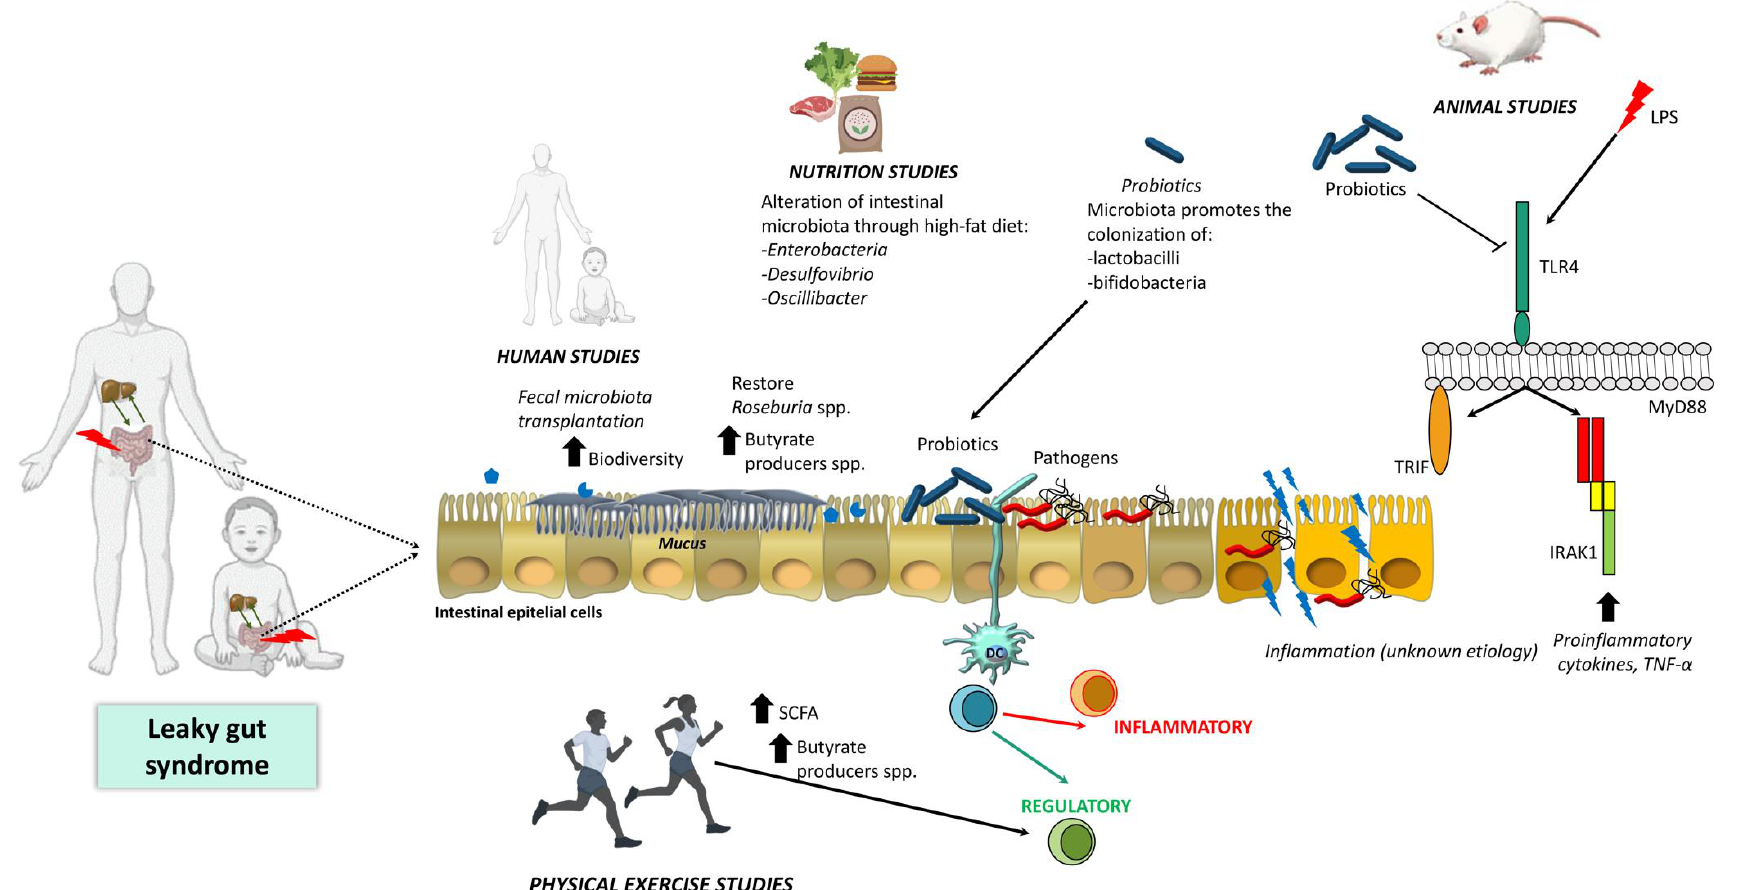
Figure 1. Main reported roles and mechanisms involving leaky gut and intestinal microbiota changes for the treatment of liver disease. Abbreviations: IRAK1, Interleukin 1 Receptor Associated Kinase 1; LPS, lipopolysaccharide; MyD88, Myeloid differentiation primary response 88; SCFA, short-chain fatty acids; TLR4, toll-like receptor 4; TNF-α, tumor necrosis factor-alpha; TRIF, TIR-domain-containing adapter-inducing interferon-β.